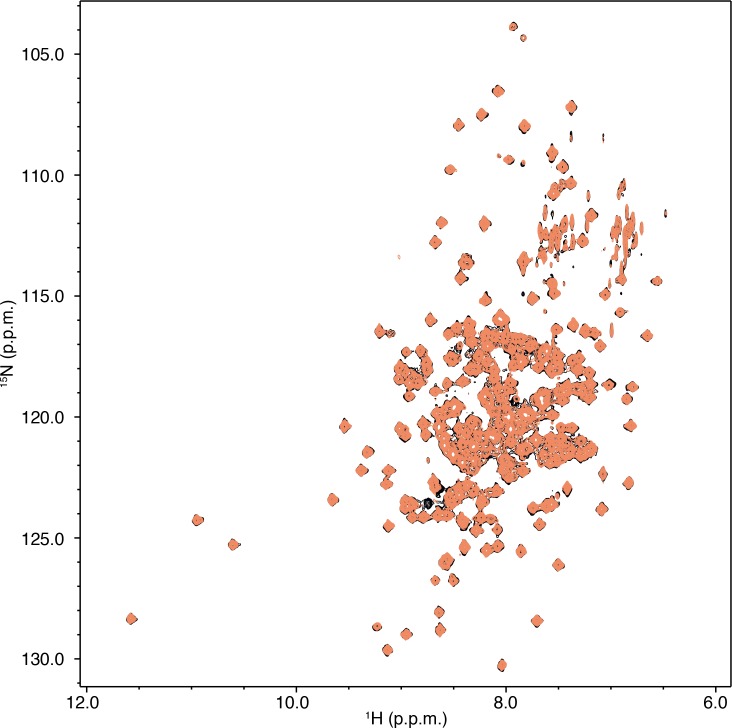
Full differential 2D [1H,15N]-TROSY-HSQC NMR data comparing native (red) vs.delipidated (black) PPARγ bound to rosiglitazone (two equiv.).